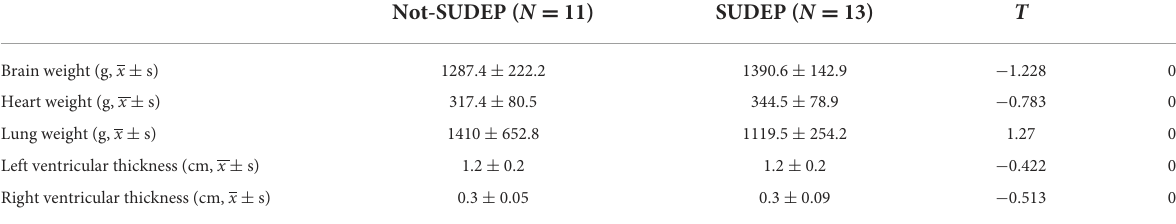
TABLE 2 Comparison of organ weight and ventricular thickness of the SUDEP